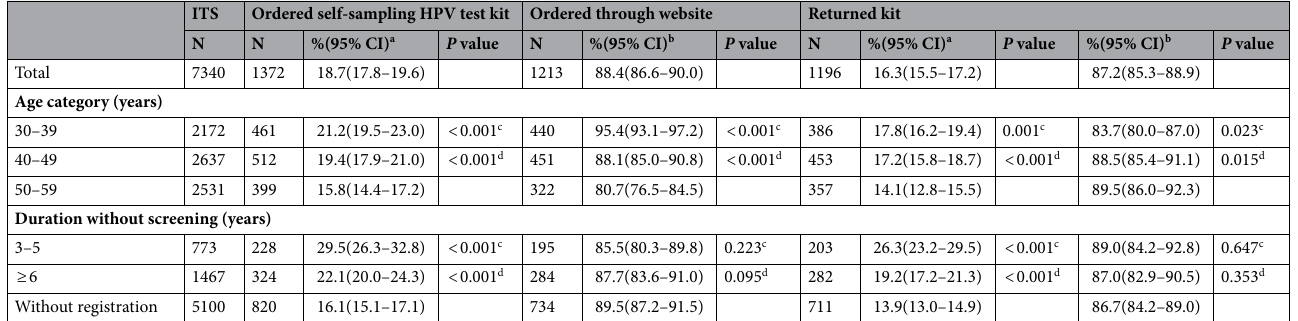
Table 2. Percentage of participants who ordered the test, ordered the test through the website, and returned a sample. CI confidence interval, ITS intention to screen, N number, HPV human papillomavirus. a Denominator is the number of ITS. b Denominator is the number of participants who ordered a self-sampling HPV test. c Pearson’s chi-square test. d Linear trend test.